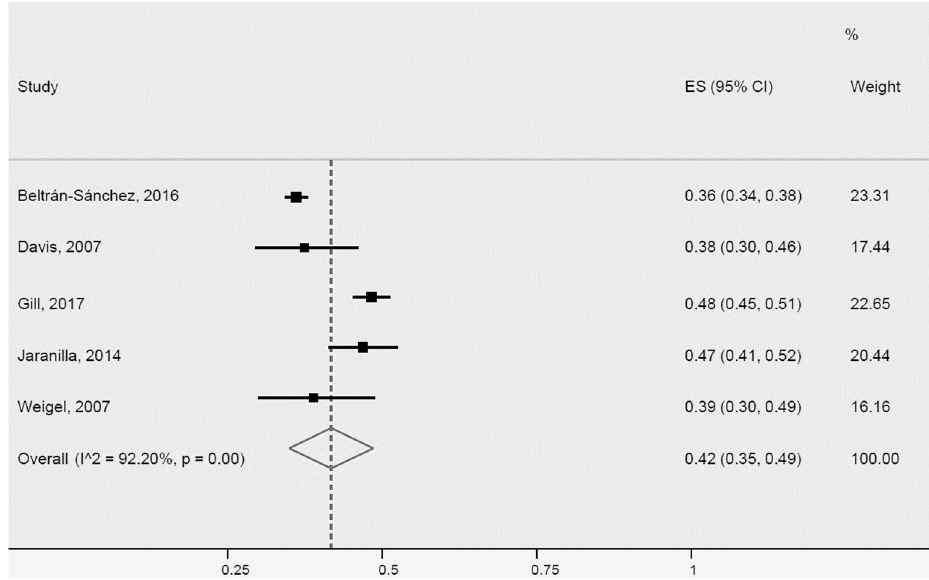
Figure 9. Low HDL cholesterol for Latinos in the US. ES = Estimated proportion/prevalence; CI = Confidence interval; I^2 = I 2 index.